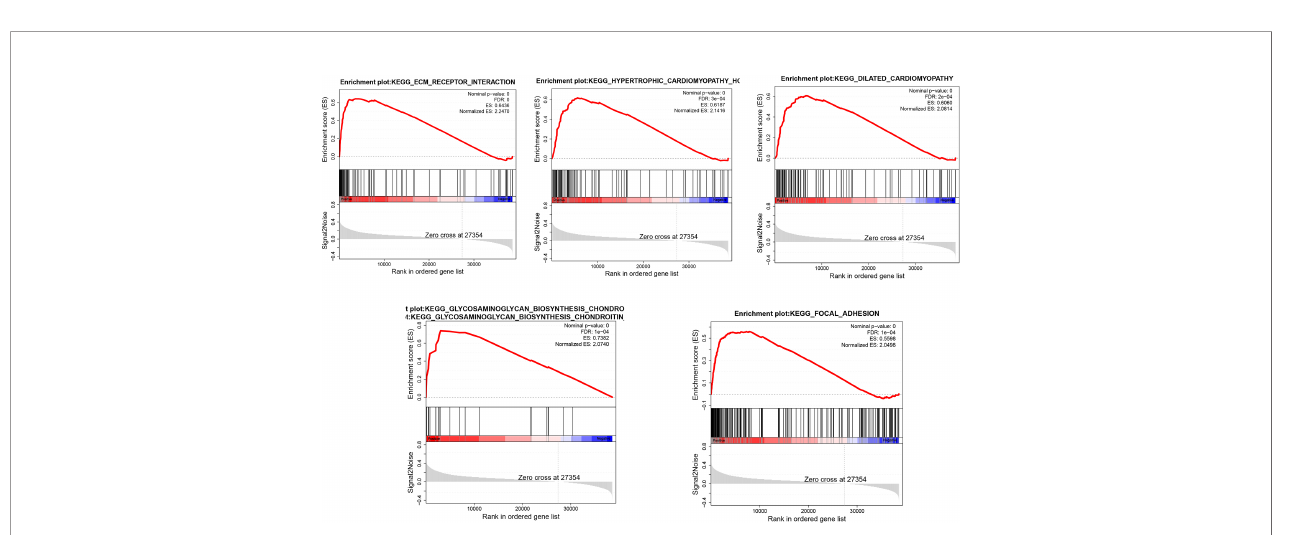
FIGURE 4 | Biological processes involved in the high expression of GSDME in gastric